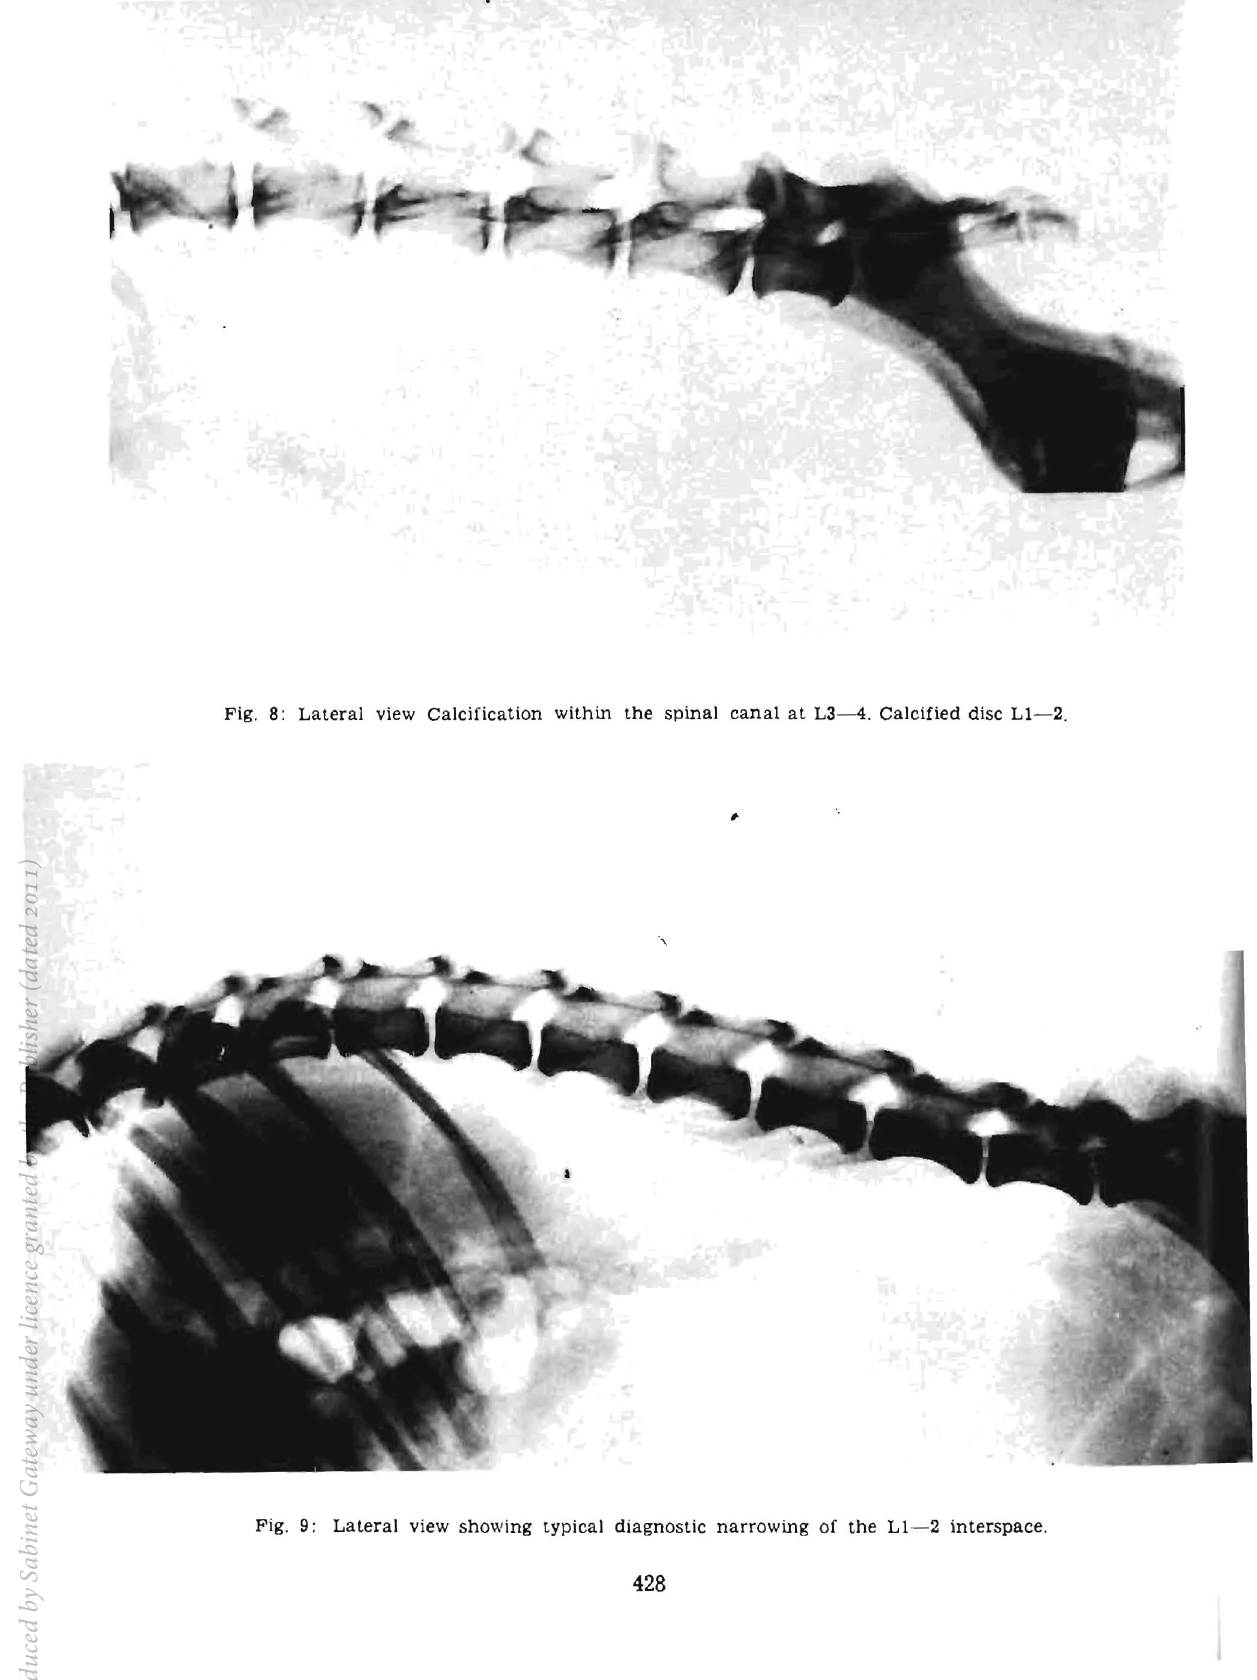
Fig. 9: Lateral view showing typical diagnostic narrowing of the LI- 2 interspace.